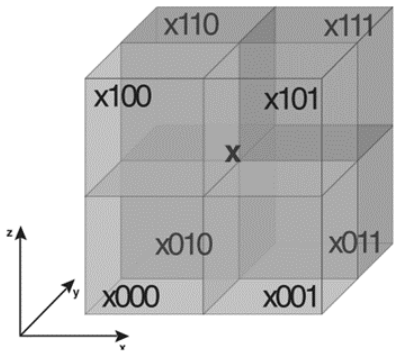
Figure 2. Marking sub ‐ frames of nodes with Morton codes.